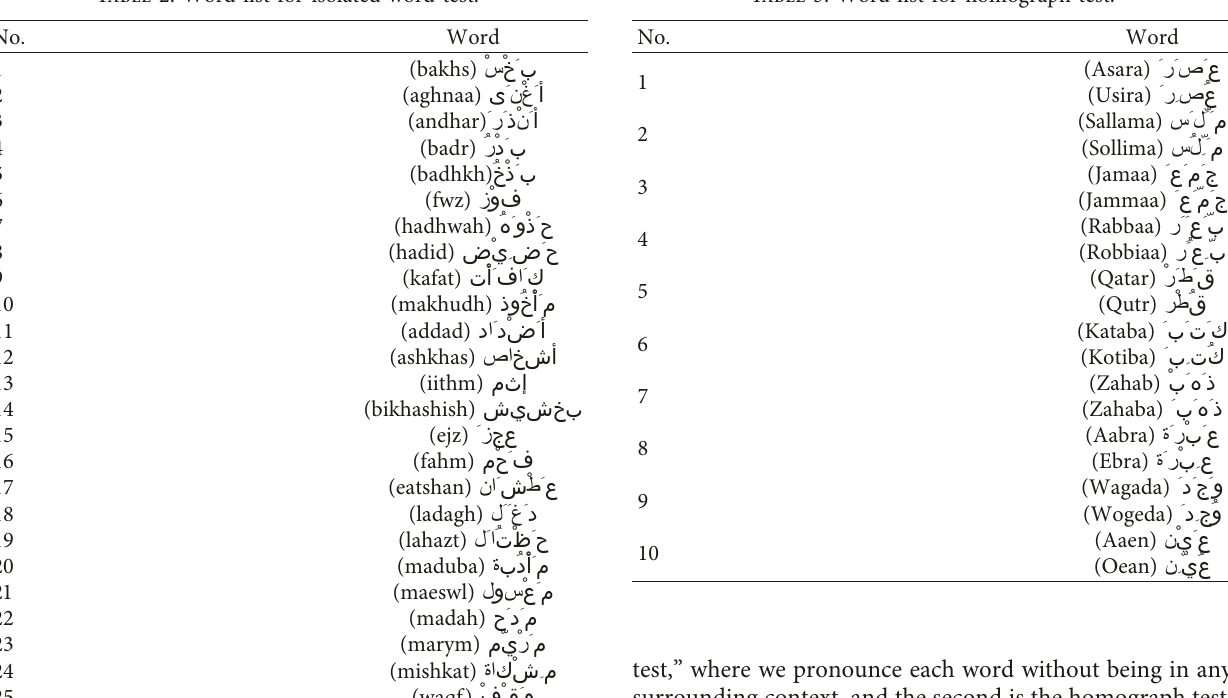
Table 2: Word list for isolated word test. Table 3: Word list for homograph